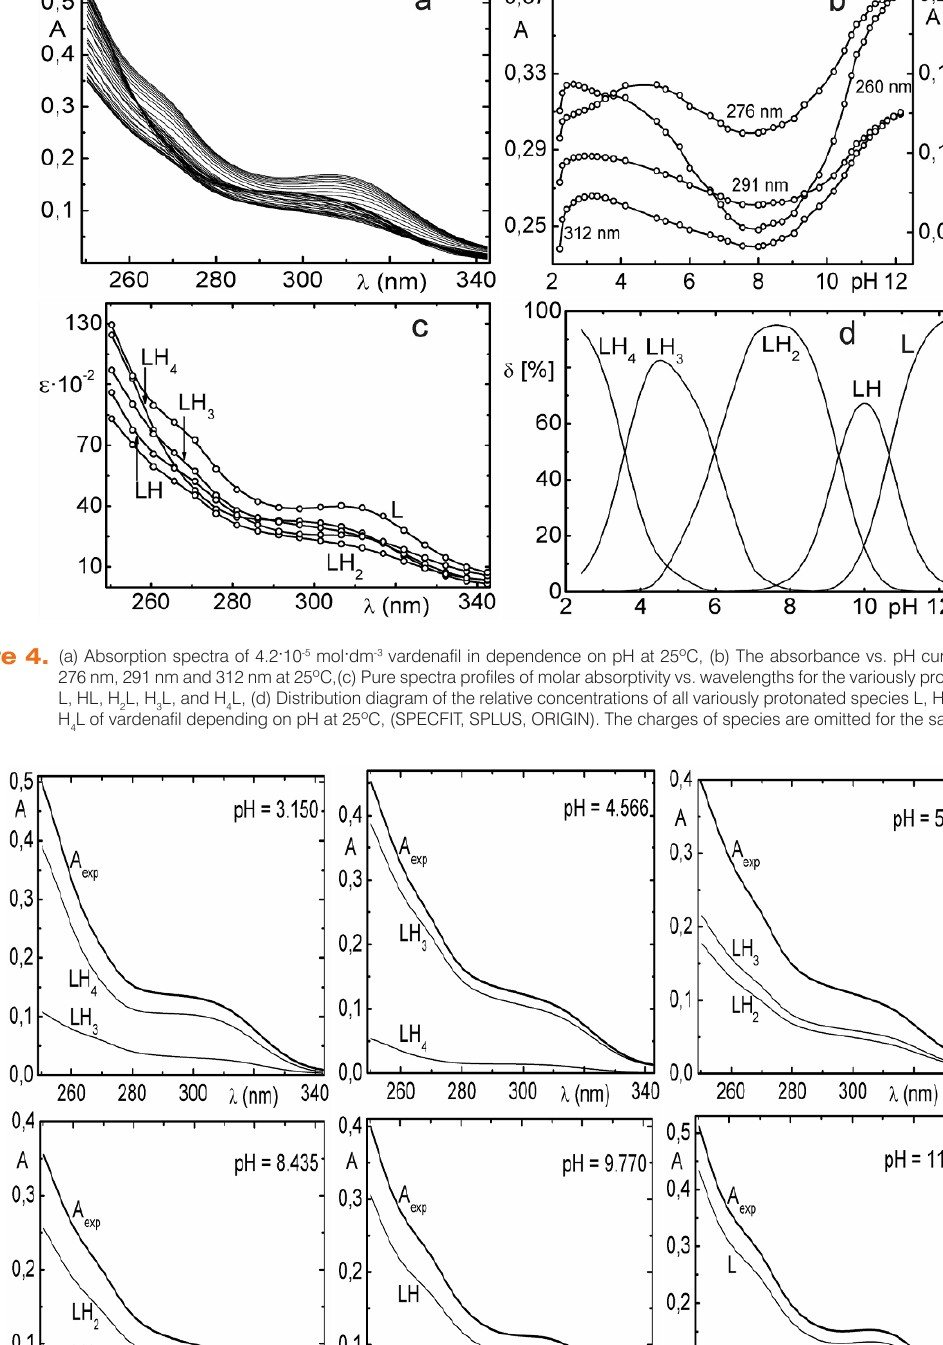
Figure 5. Decomposition of the experimental absorption spectrum of vardenafil for ( n = 46, m = 19) into the spectra of the individual variously protonated species L, HL, H L, H L, and H L in solution of each particular absorption spectrum for a selected value of pH equal 3.150, 2 3 4 4.566, 5.998, 8.435, 9.770 and 11.252. The charges of species are omitted for the sake of generality (SQUAD,